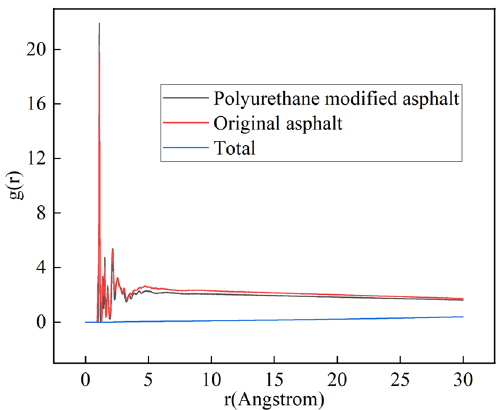
Figure 13: Radial distribution function.